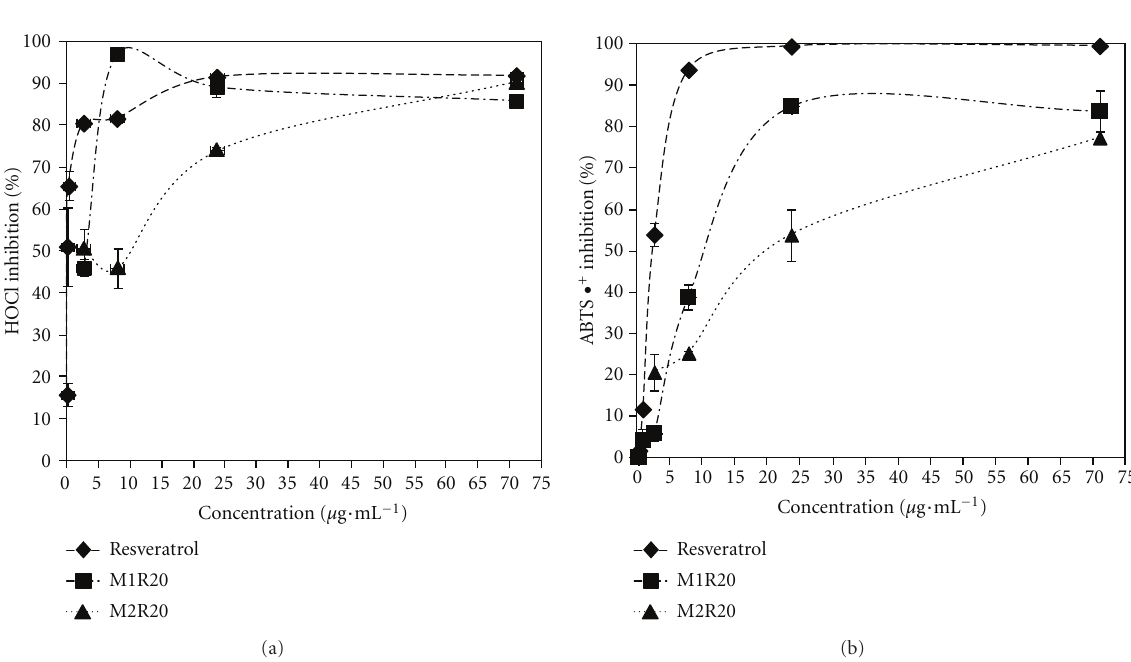
Figure 9: Antioxidant e ff ect of pure resveratrol, and PHBV/PCL microparticles by HOCl- (a) and ABTS • + - (b) scavenging activity.